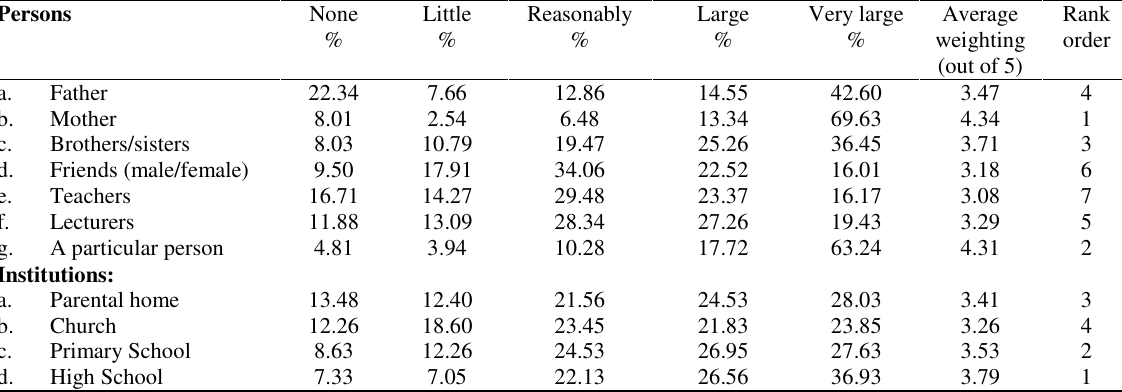
Table 3 The influence of role-players on the character-development and character-building of students